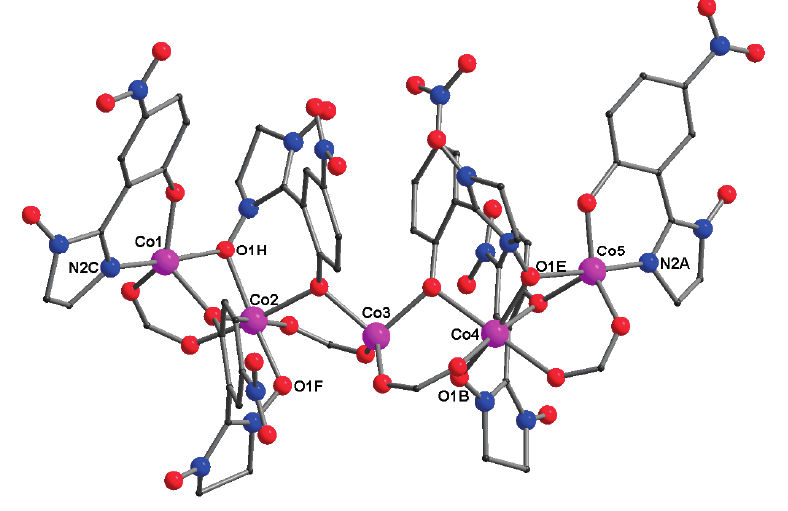
Figure 2. Structure of the pentanuclear [Co 5 (Piv) 4 L 1 4 L 2 ]